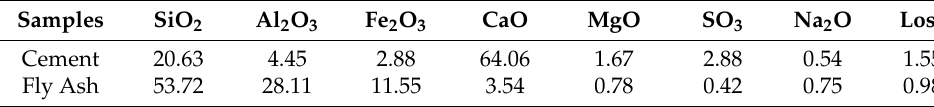
Table 1. Chemical composition of fly ash and cement (by weight, %).